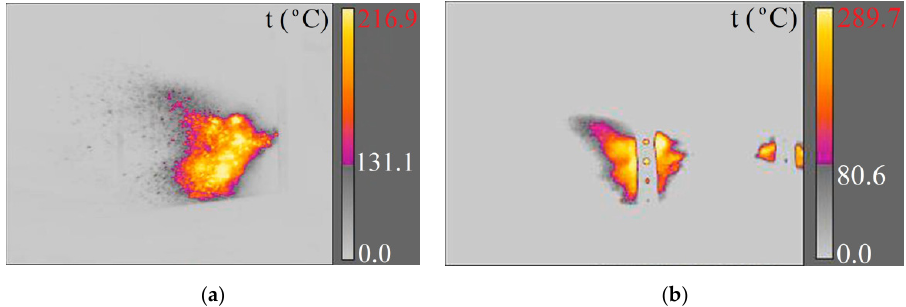
Figure 9. Piercing a concrete sidewalk slab with a 7.62 × 54R B ‐ 32 projectile recorded with cameras: ( a ) X6580sc (660 fps); ( b ) A6901scSLS (2615 fps).